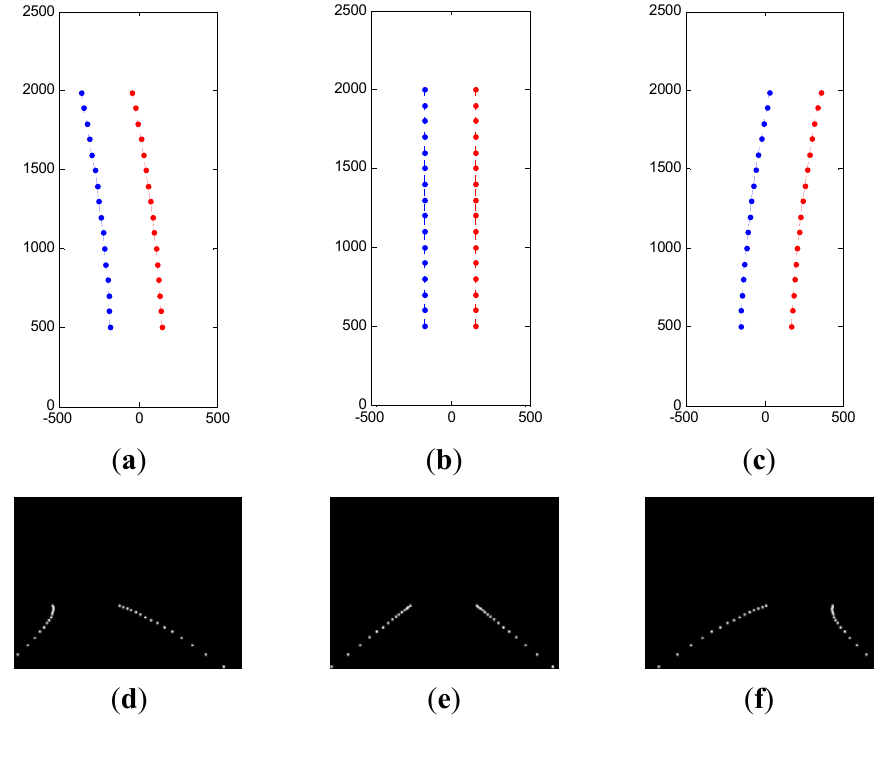
Figure 3. Examples of lane models and corresponding projection images lane model layouts with ( a ) positive curvature, ( b ) zero curvature, and ( c ) negative curvature. ( d – f ) are the corresponding projection images of lane models in